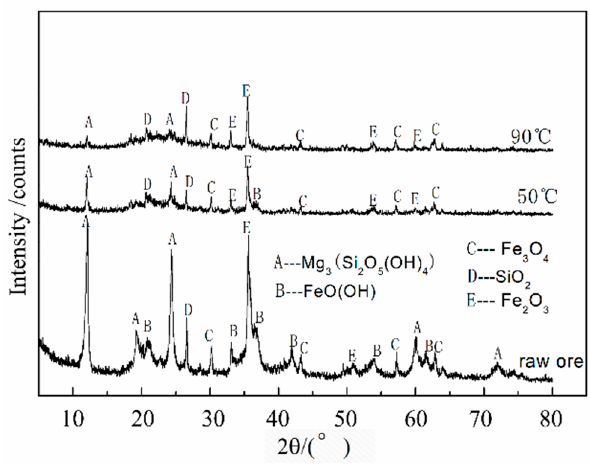
Figure 3. Leaching residues’ XRD diagram at different leaching temperatures.